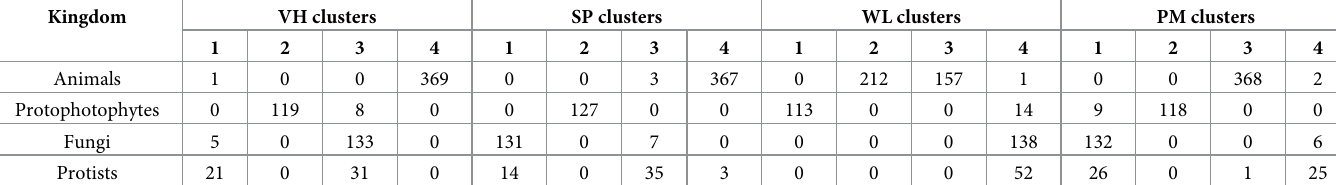
Table 3. Eukaryotes test, kingdom level: Distribution of Eukaryotes into four groups for every graph kernel. Kingdom VH clusters SP clusters WL clusters PM clusters 1 Animals Protophotophytes